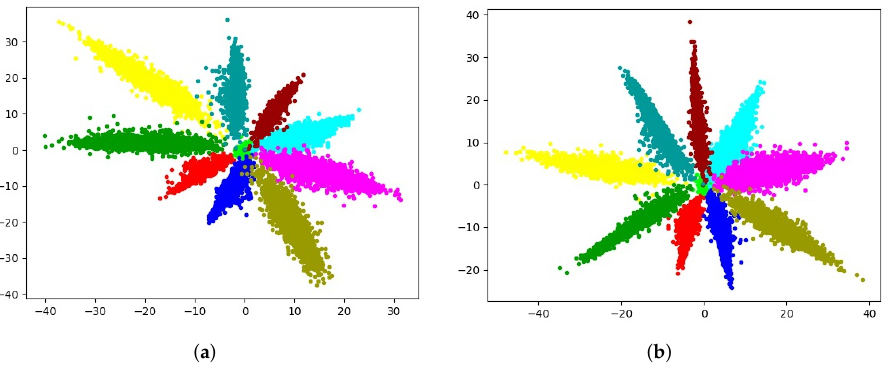
Figure 4. The feature embedding of ResNet-110 on the CIFAR-10 dataset. The network is trained with the cross-entropy loss and updated by SGD. Each color on the picture represents a category of the CIFAR-10 dataset. ( a ) Baseline. ( b ) Random learning rates.